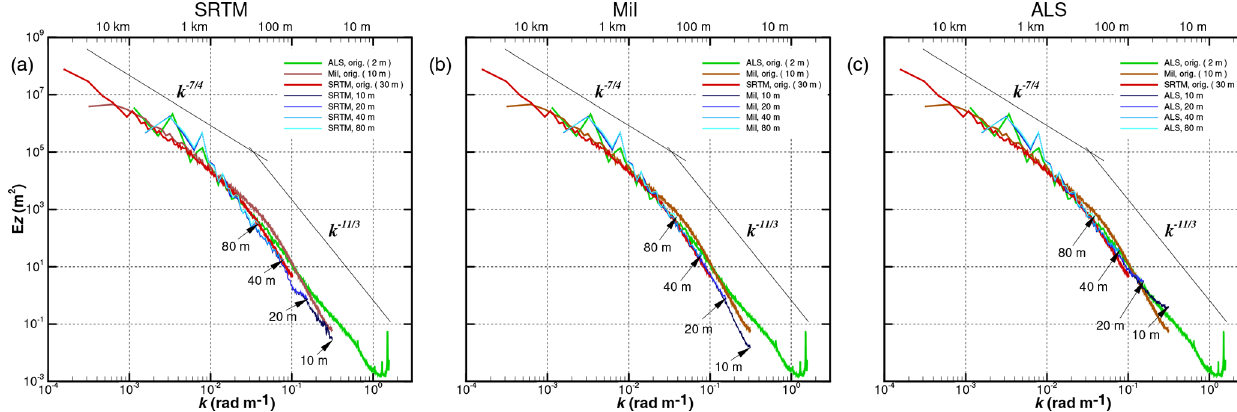
Figure 11. Spectra analysis for DTM and meshes: (a) SRTM, (b) Mil, (c)